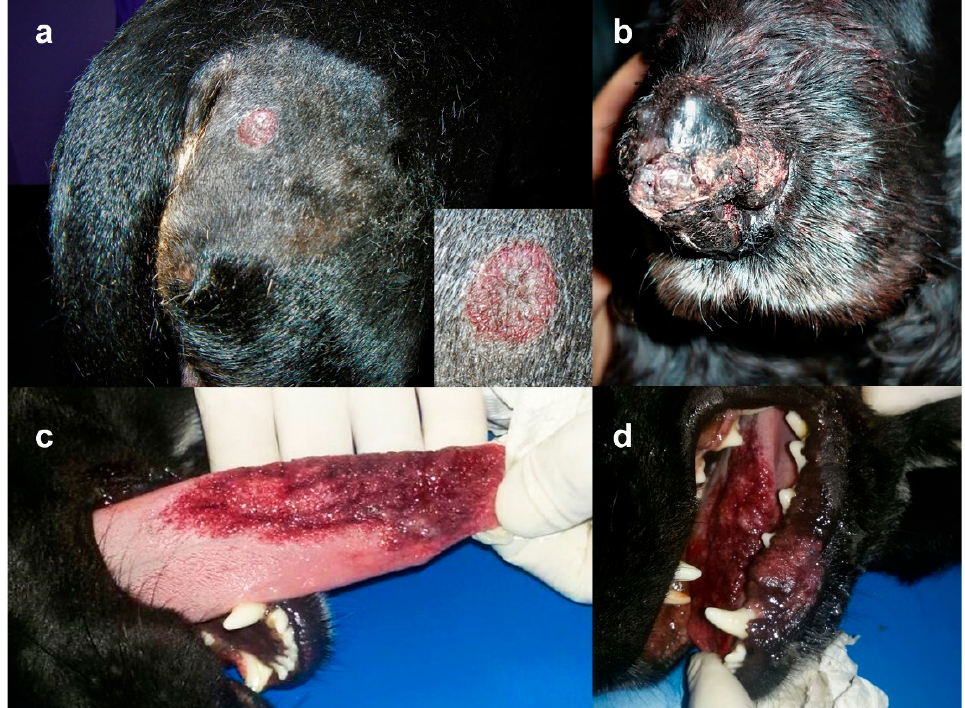
Figure 1. Clinical presentation of CPA. ( a ) Case N 9: round alopecic and erythematous plaque lateral to the tail base (detail of the lesion in the inset); ( b ) Case N 16: multiple hemorrhagic, crusted, confluent plaques and nodules on the muzzle; ( c ) Case N 17: large hemorrhagic plaques on the inferior lip and tongue (Courtesy dr. Paolo Persico); ( d ) Case N 17: a closer view of the hemorrhagic plaque on the tongue.